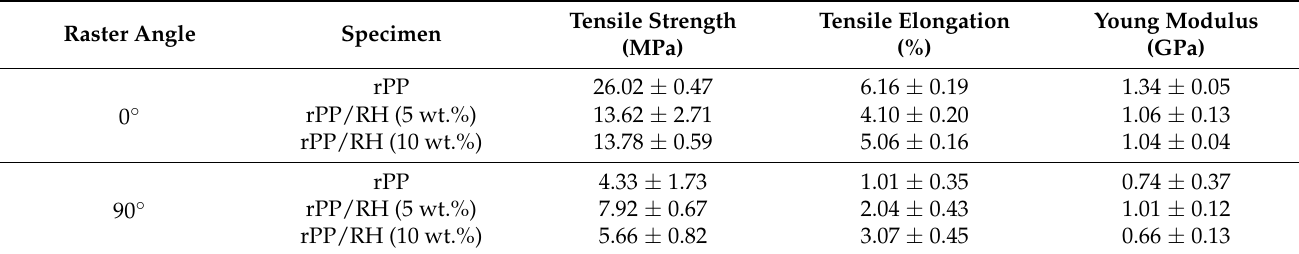
Table 3. Mechanical properties of rPP and rPP/RH composites at different raster angles. Raster Angle